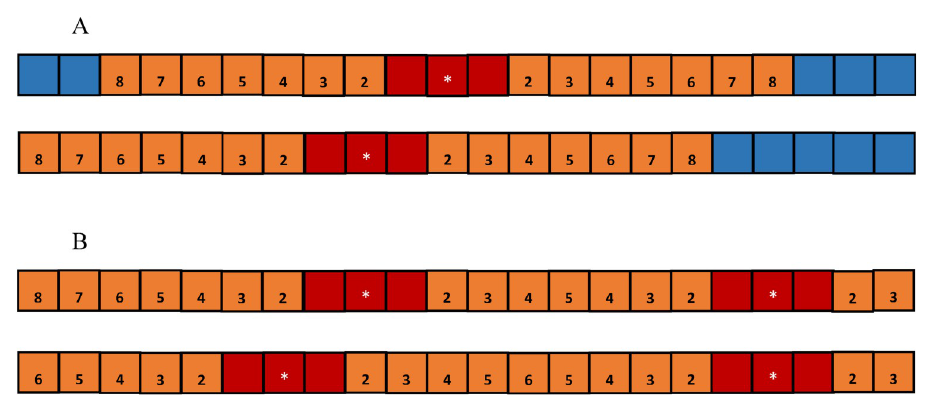
Fig 1. Illustration of weighted sizes of the hot, warm, and cold zones of one AED and two AEDs. (Fig 1A, top) An AED is placed at the 11 th square from the left. The hot, warm, and cold zones are colored red, orange, and blue, (cid:0) � ¼ 481 3, A 5, and A ¼ 2 1 þ 1 þ ��� þ 1 . (Fig 1A, respectively. For this example, the weighted sizes are A H = C = W 2 3 8 140 bottom) If we place the AED at the 9 th square, the weighted sizes of hot, warm, and cold zones remain the same. The rescue benefit of this location is the same as that of the previous one. (Fig IB, top) An AED is placed at the 9 th square from the left, and another AED is placed at the 4 th square from the right. The hot and warm zones are colored red and orange, respectively. For this example, there is no cold zone, and the weighted sizes of the hot and warm zones are A H ¼ 4131 (Fig IB, bottom) If we move the left AED to the 7 th square, the weighted sizes of hot and warm zones = 6 and A W 840 become different, with A = 6 and A ¼ 4439 . Therefore, moving the AEDs to the 7 th square results in a better rescue H W 840